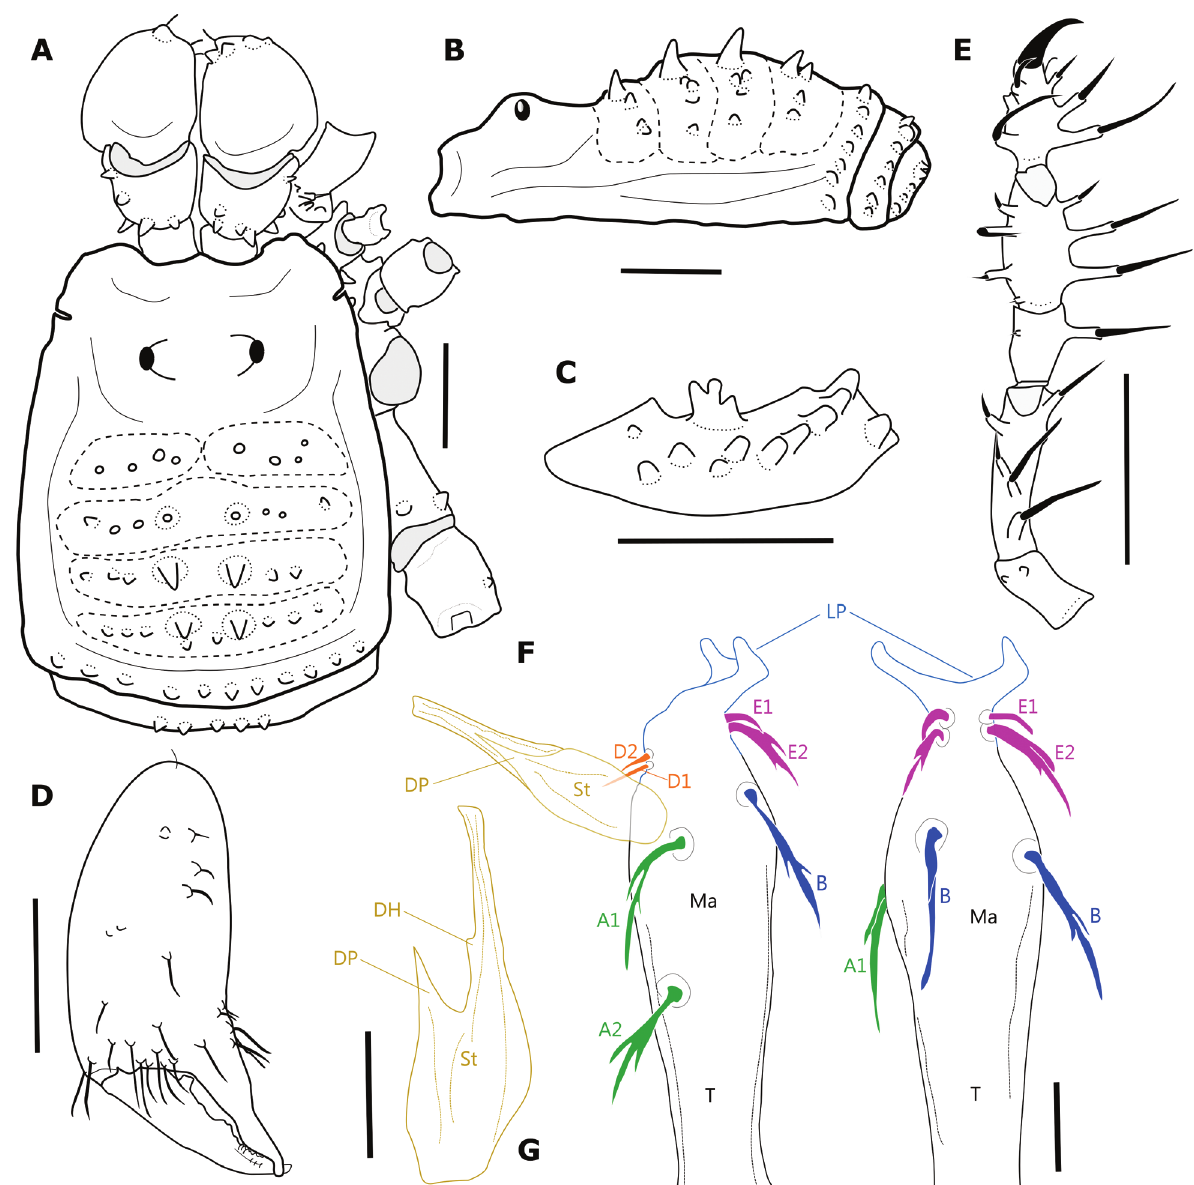
Figure 2. Drawings of Barinas guanenta sp. nov. Male holotype (ICN-Ao-742.1) habitus in dorsal ( A ) and lateral ( B ) views; coxa I, ventral view ( C ); chelicera, frontal view ( D ); right pedipalp, mesal view ( E ). Male paratype (ICN-Ao-742): genitalia in lateral and ventral views ( F ); detail of stylus ( G ). The colored letters A-D refers to the chaetotaxy system of Kury and Villarreal (2015). Abbreviations: DH―dorsal hump, DP―dorsal process, LP―lamina parva, Ma―malleus, St―stylus, T―truncus. Scale bars: 0.5 mm ( A-E ); 0.05 mm ( F,G